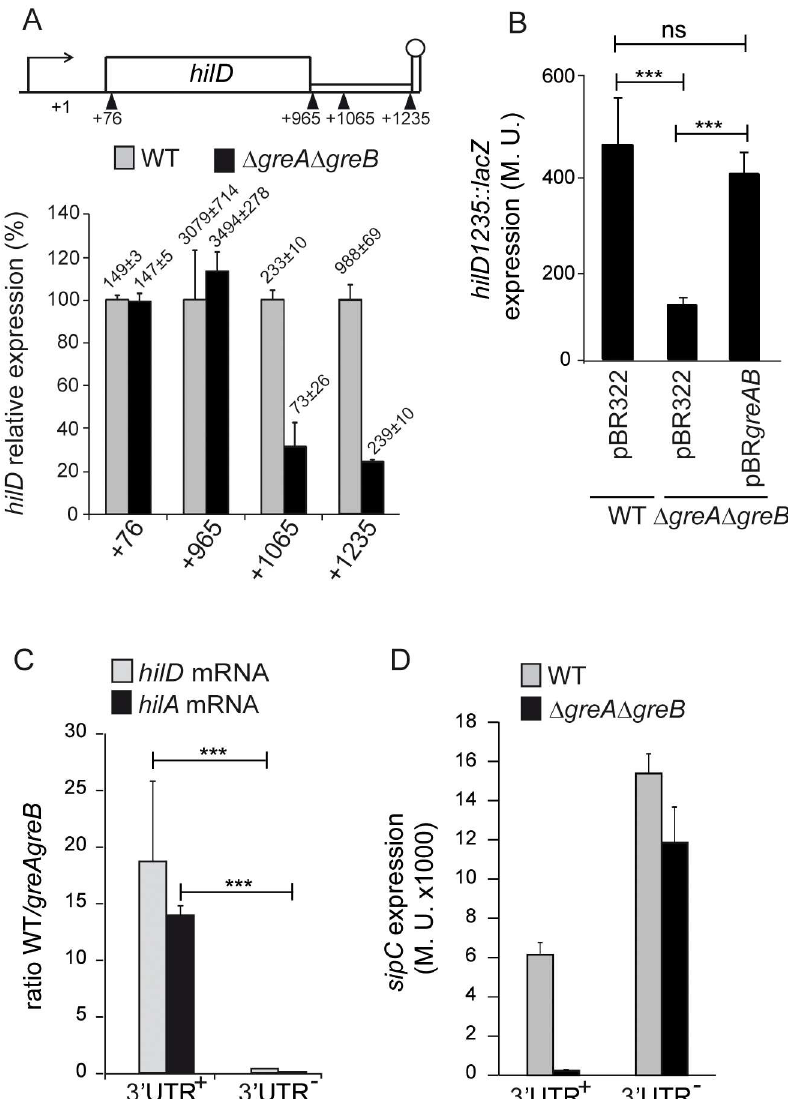
Fig 6. The 3’UTR of hilD is required for the Gre-mediated regulation. (A) Transcriptional expressionfrom hilD :: lacZ chromosomalfusions at positions+76, +965, +1065 and +1235 (relative location in the hilD gene is indicatedin the upper panel). β -galactosidase activity was monitored in LB cultures grown at 37˚C up to an OD 600nm of 2.0.of both WT and Δ greA Δ greB strains carryingthe indicatedfusions. (B) hilD 1235 :: lacZ transcriptional expressionwas tested in cultures of WT and Δ greA Δ greB derivative strains carrying the indicatedplasmids. β -galactosidase activity was determinedas in A. (C) Ratio in the levels of hilD and hilA transcripts betweenWT and Δ greA Δ greB strains in hilD 3’UTR+and hilD 3’UTR- geneticbackgrounds. mRNA levels were monitoredby qPCR using detectionof gapA (GAPDH) as an endogenous control. Total RNA was isolatedfrom cultures grown as in A. (D) Transcriptional expressionfrom a sipC :: lacZ chromosomal fusion. β -galactosidase activity was monitored as in A in cultures of both WT and Δ greA Δ greB strains in both hilD 3’UTR + and hilD 3’UTR - genetic backgrounds. In all panels, a bar shows the arithmetic mean of experimental results and the error bar indicatesthe standard deviationfrom three biological replicates. In B and C, to assess differencesin the values, an unpaired,two-sidedStudent’stest was performed. Statistical significanceis indicatedby *** p < 0.001, ns: